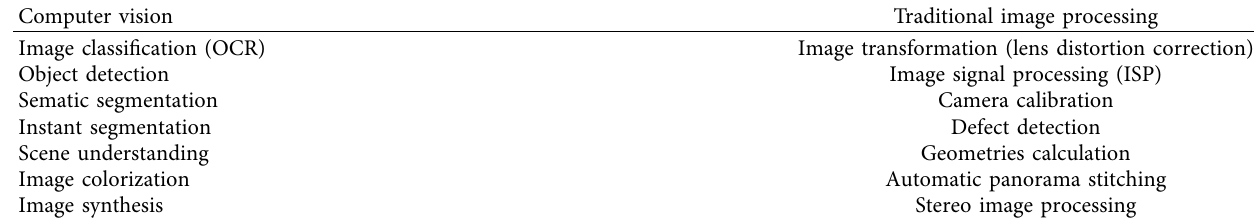
Table 2: Applications of traditional image processing and computer vision